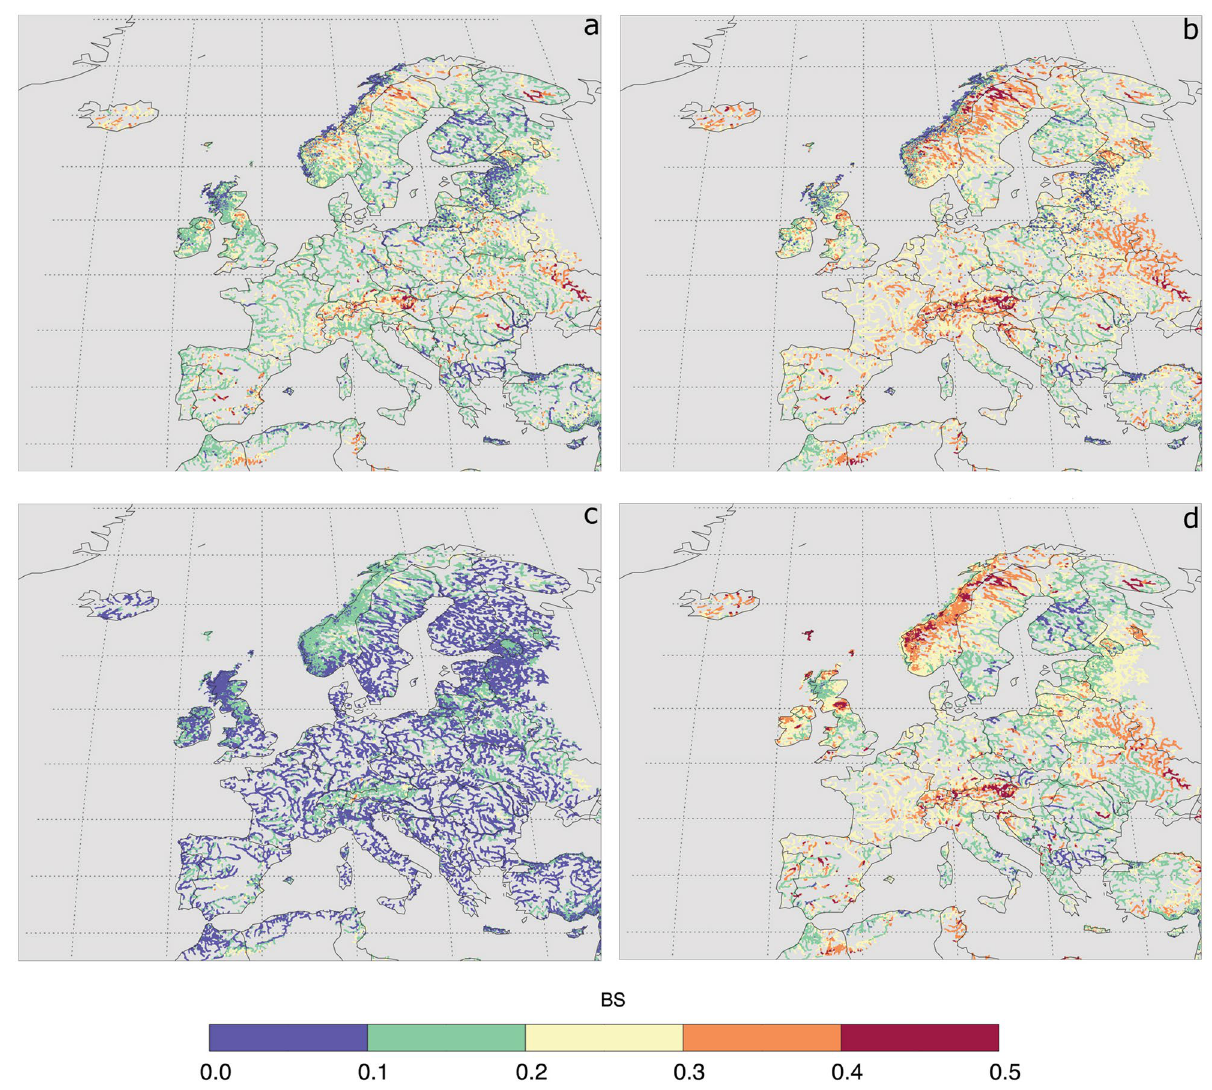
Figure 1. Drought forecast performance denoted by the Brier Score (BS) for major European rivers: ( a ) BS for SSI-1 with Lead Time (LT) = 1-month, ( b ) BS for SSI-1 with LT = 3-month, ( c ) BS for SSI-3 with LT = 1-month, and ( d ) BS for SSI-3 with LT = 3-month. Note all figures were plotted using the Interactive Data Language (IDL) software version 8.0 (https:// www. l3har risge ospat ial. com/ Softw are- Techn ology/